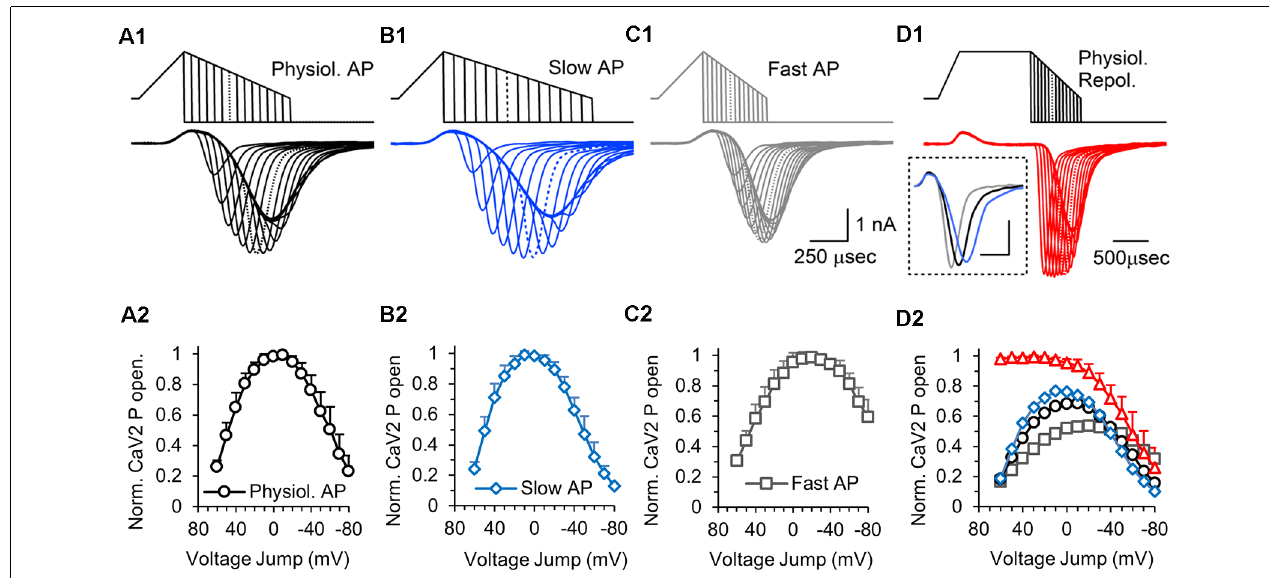
FIGURE 6 | Effects of action potential repolarization duration on the number of presynaptic calcium channels that are activated at different times during the action potential. (A1) The top traces show a series of hyperpolarizing voltage-jumps, 15 in total, that were delivered at different times during the repolarization phase of a physiological AP-like stimulation. The bottom trace shows the overlaid presynaptic calcium channel responses to each voltage-jump. The peak amplitude measures the relative number of calcium channels that are active at each point during the repolarization. Dotted lines in the stimulus and response traces indicate the maximum response. Panels (A1–D1) show representative traces recorded from a single cell. (A2) Graph of the CaV2 open probability for a physiological AP stimulus, measured by the average CaV2 peak response to each voltage-jump, normalized to the maximum response for each cell. Panels (A2–D2) , n = 6 cells, with all 60 stimuli tested in each cell. The data points are the average of the normalized responses from each cell. (B1) Responses to hyperpolarizing voltage-jumps during an AP-like stimulation with a slow repolarization phase. (B2) Graph of the CaV2 open probability for a slow AP-like stimulus, measured by the average CaV2 peak response to each voltage-jump during, normalized to the maximum response (at +10 mV). (C1) Responses to hyperpolarizing voltage-jumps during an AP-like stimulation with a fast repolarization phase. (C2) Graph of the CaV2 open probability for a fast AP-like stimulus, measured by the average CaV2 peak response to each voltage-jump, normalized to the maximum response (at − 20 mV). Inset shows (D1) . Prolonged depolarization to open all available presynaptic calcium channels followed by a series of hyperpolarizing voltage-jumps during an AP-like repolarization phase. Inset shows the full response to AP-like stimulation without a voltage jump for a normal (black), fast (blue) or slow (gray) repolarization (scale bar: 0.5 ms, 1 nA). (D2) Graph of the average CaV2 open probability for all four stimuli tested normalized to the responses to the long depolarization (D1) stimulus which should produce the maximum CaV2 open probability: long-depolarization (red